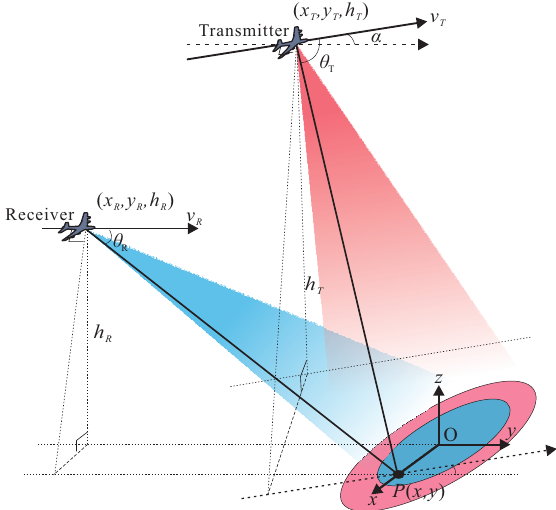
Figure 1. Imaging geometry configuration of translational variant bistatic forward-looking synthetic aperture radar